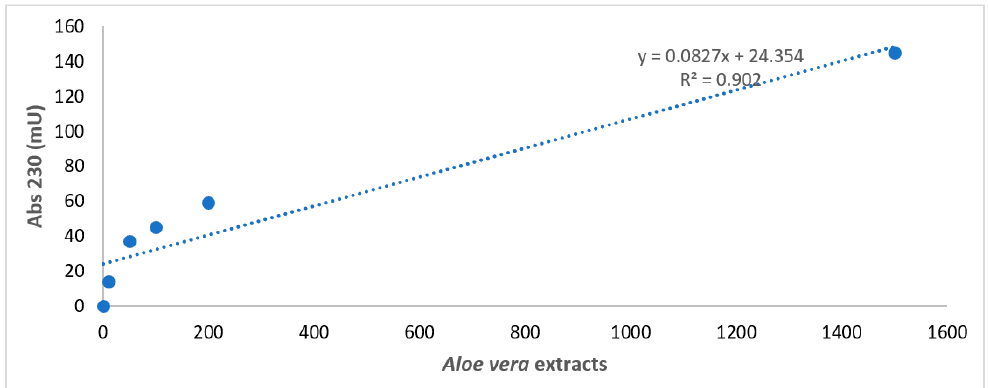
Figure 1. Spectrophotometer analysis of Aloe vera extracts. Spectrophotometer analysis of Aloe vera extracts obtained by diluting the extract to 1 / 1, 1 / 10, 1 / 50, 1 / 100, and 1 / 200 in a physiologic solution with a standard reference curve. X axis: wavelength in nm. Y axis: absorbance intensity at 230 nm. The time course releases of Aloe vera extract from lenses, as evaluated by UV nano-spectrophotometry, are reported in Figure 2.